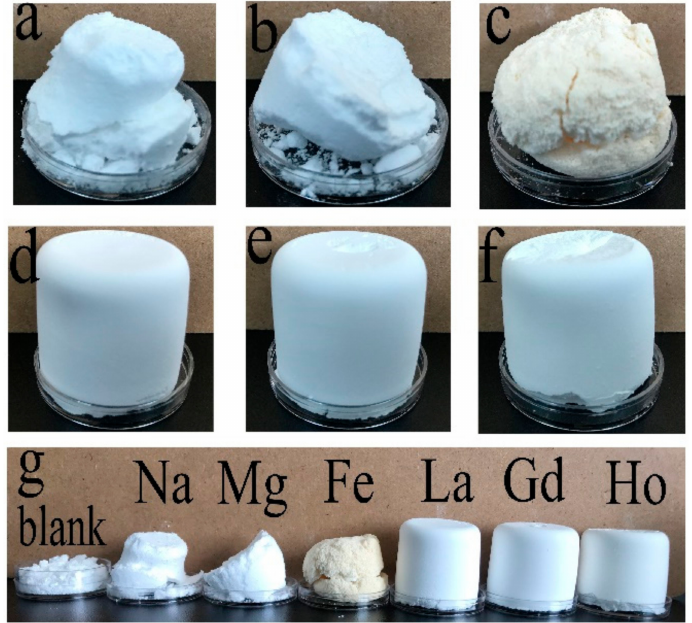
Figure 1. Photographs of samples obtained after adding di ff erent metal ions: ( a ) Na, ( b ) Mg, ( c ) Fe, ( d ) La, ( e ) Gd, and ( f ) Ho. ( g ) Samples in a photo for comparison.